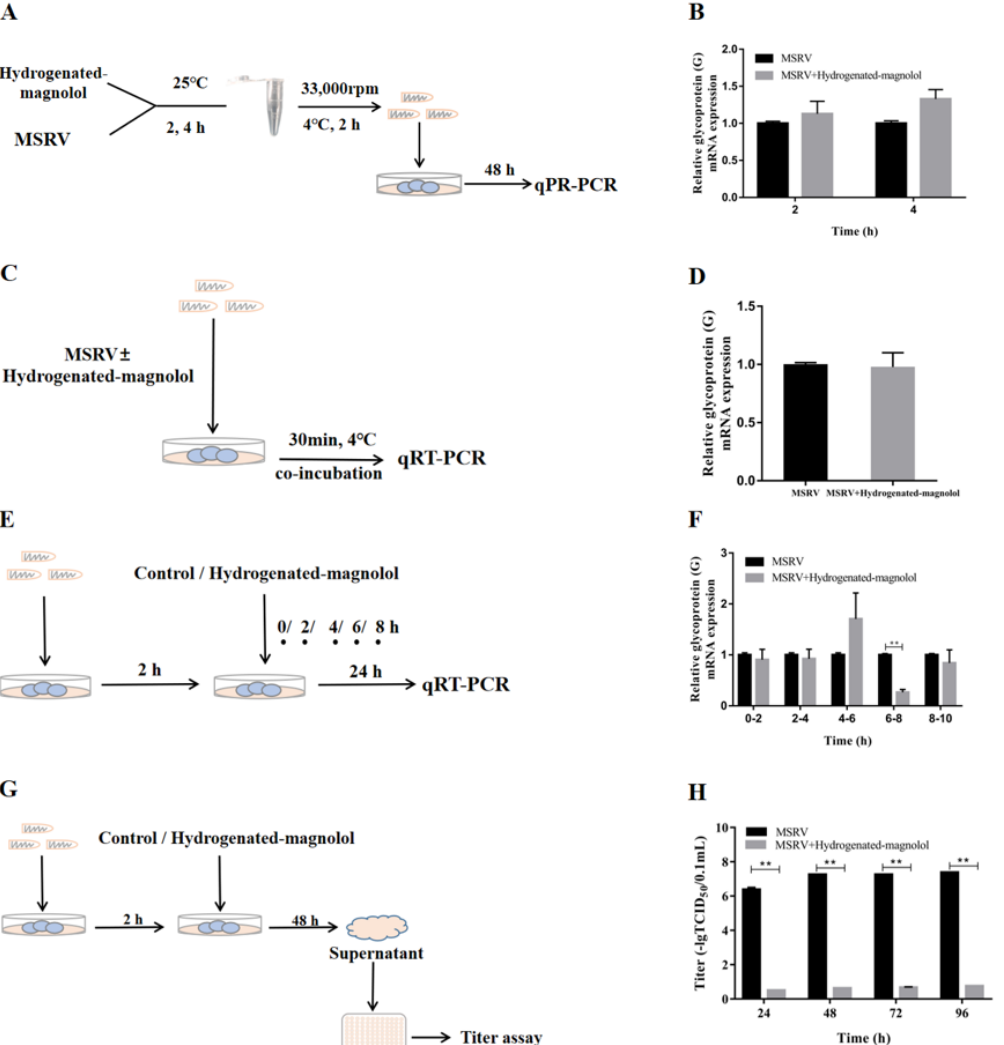
Figure 7. Effect of hydrogenated magnolol on MSRV infection steps in GCO cells. ( A , C , E , G ) illustrate the workflows of the assay design followed in ( B , D , F , H ), respectively. ( B ) The infectivity of MSRV was not affected by hydrogenated magnolol. ( D ) MSRV adhesion was not influenced by hydrogenated magnolol. ( F ) The replication of MSRV in the 6–8 h period was inhibited by hydrogenated magnolol. ( H ) The release of MSRV particles in GCO cells was restrained by hydrogenated magnolol. Relative glycoprotein G gene expression was analyzed by qRT-PCR and calculated on the basis of the 2 −ΔΔ Ct method. The viral titers in the supernatant were calculated using the Karber method at the indicated times. Error bars indicate the SEM. ** p < 0.01.